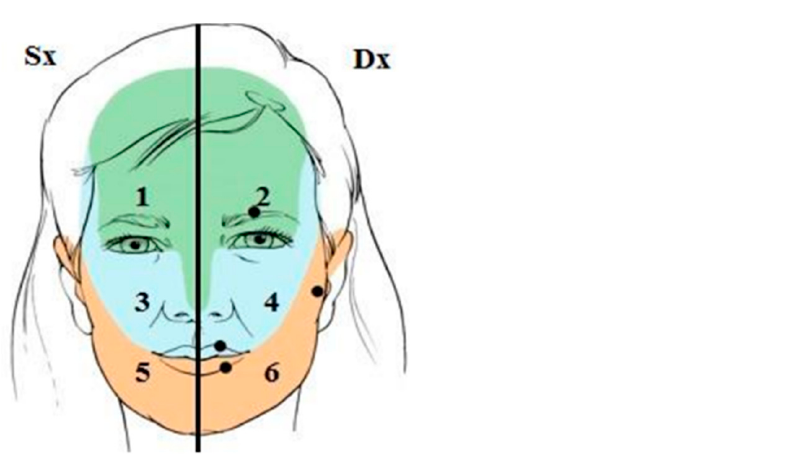
Figure 1. Template showing the six areas based on the trigeminus branches innervation.